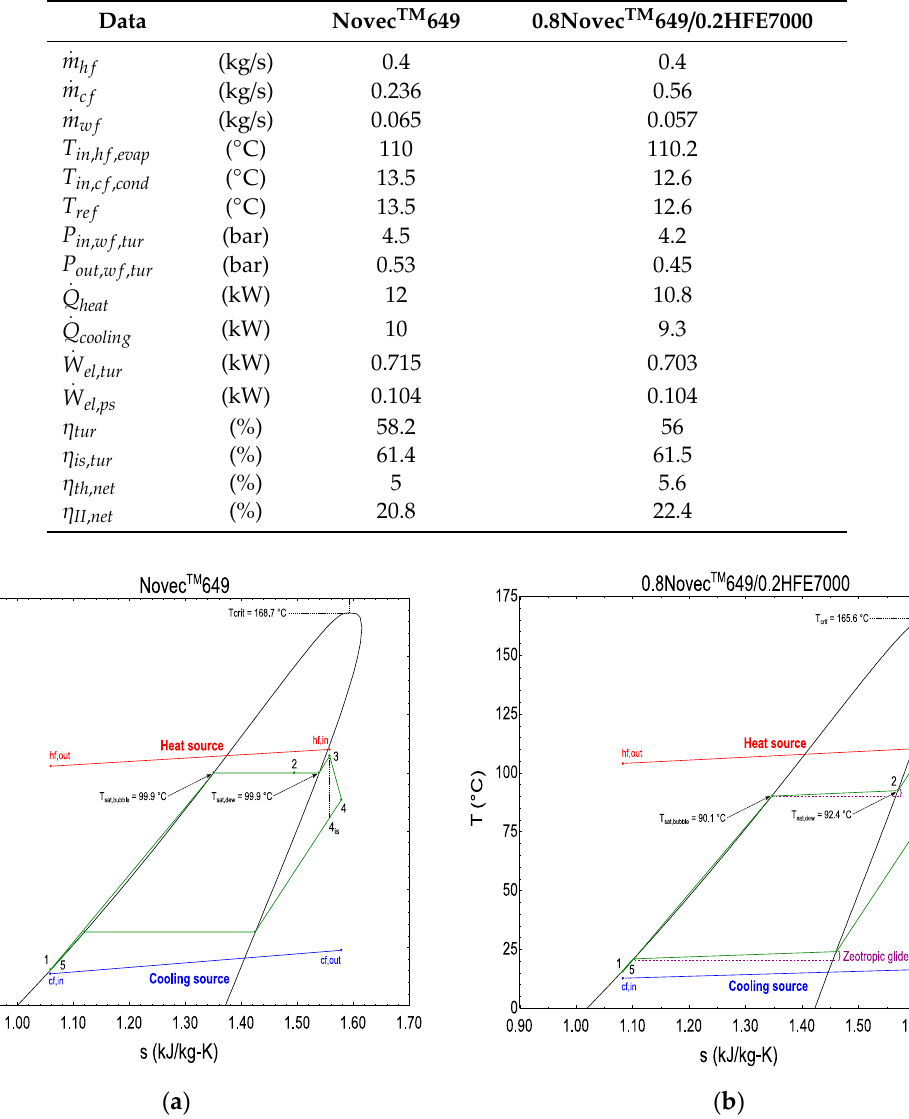
Figure 8. The T-s plot of the ORC cycle corresponding to the highest experimental point regarding electrical production: ( a ) Novec TM 649; ( b ) 0.8Novec TM 649/0.2HFE7000. 395